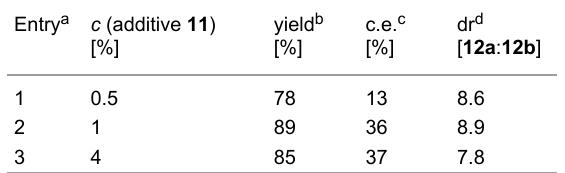
Table 4: Influence of the concentration of additive 11 on the electrore- duction of 7b